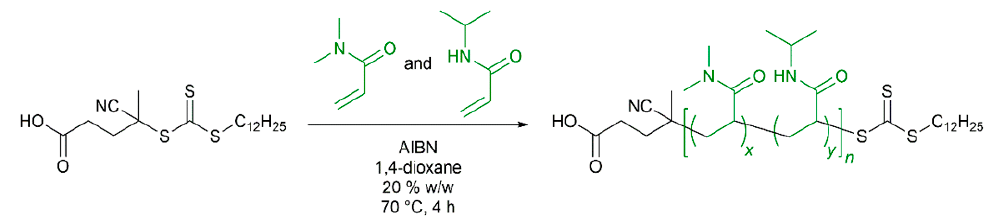
Figure 1. Synthesis of poly(( N,N -dimethyl acrylamide)- co -( N -isopropyl acrylamide)) (P(DMA- co - NIPAM)) via RAFT solution polymerization in 1,4-dioxane (25% ( w/w )).